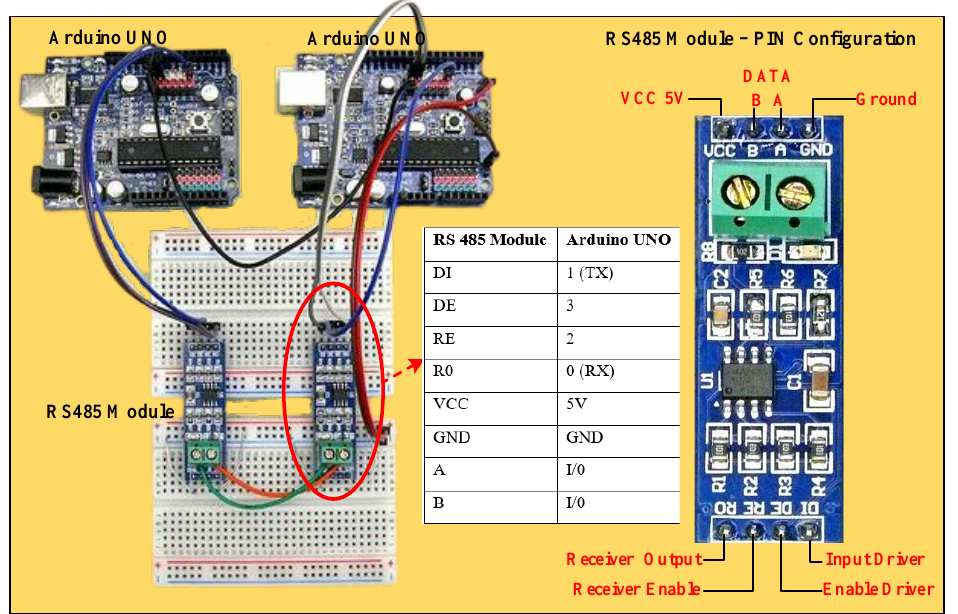
Figure 12. Arduino connections with Modbus.